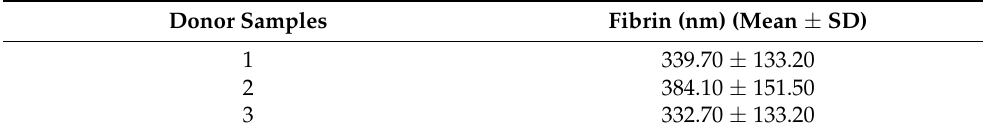
Figure 5. Highly dense and interconnected 3D fibrin microarchitecture in cross-sections of intact Ly- PRF. (SEM; original magnification: ( A ) ×1700, ( B ) ×1400, ( C ) ×1300, ( D ) ×2000, ( E ) ×1,000 and ( F ) ×1300). (Bar = 10 µm). ( A , B ) Donor 1; ( C , D ) Donor 2; ( E , F ) Donor 3. Table 3. Comparative Ly-PRF fibrin